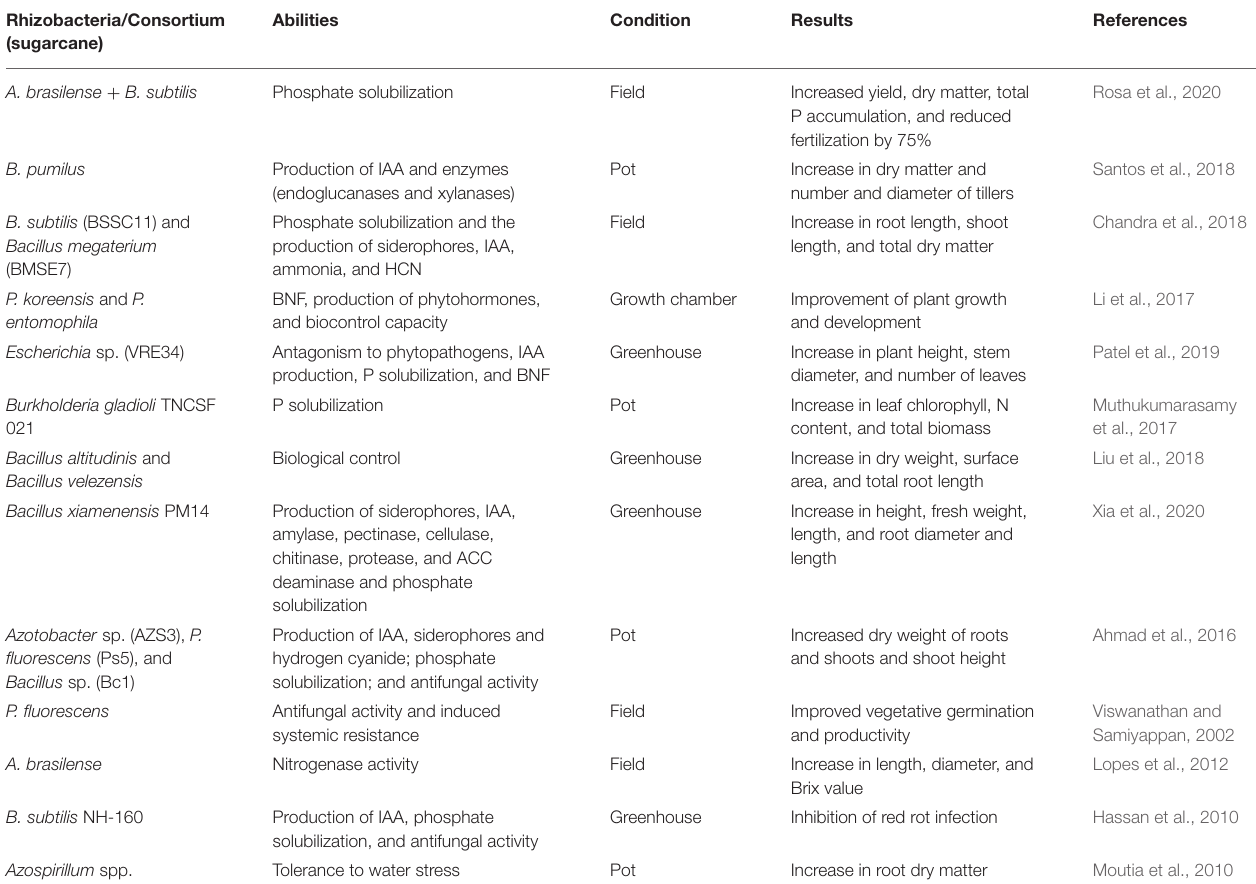
TABLE 2 | Bacteria specie, abilities, experiment condition, and results promoted by the application of many plant growth- promoting rhizobacteria in